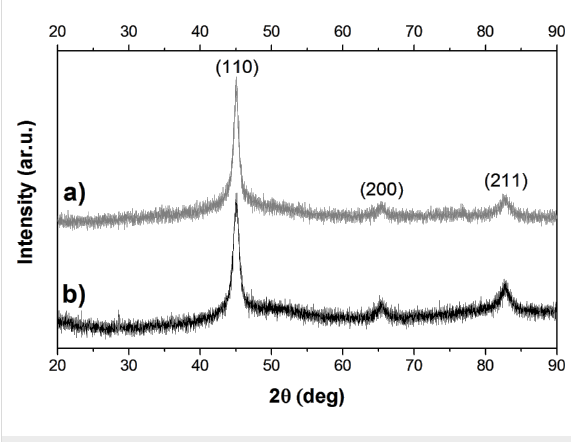
Figure 3: XRD patterns of a) iron nanowires and b) iron nanoparticles. Miller indices of α -Fe are given based on JCPDS no.